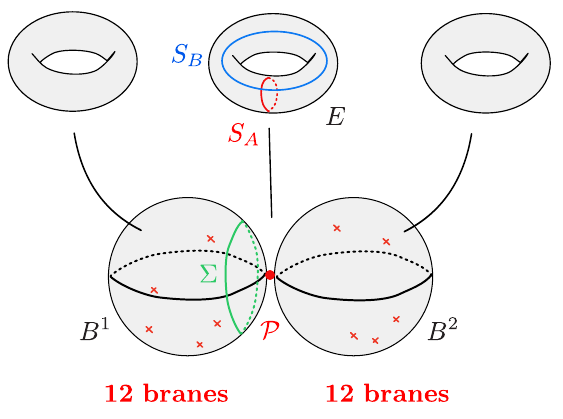
Figure 5 . Kulikov Type II.a degeneration. The base degenerates into two P 1 s that form the bases of two elliptic del Pezzo surfaces dP 9